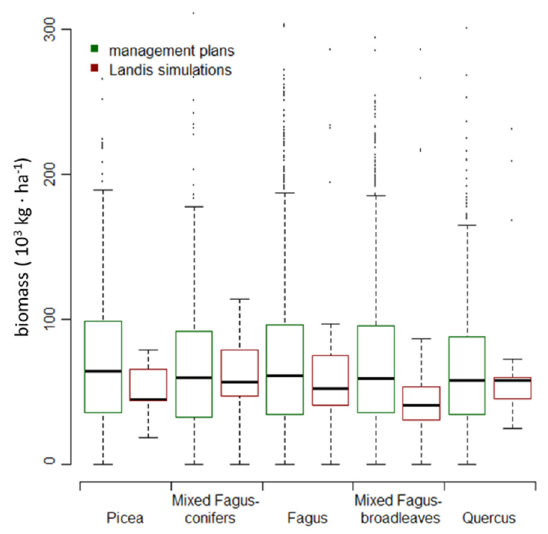
Figure 3. Boxplot diagram comparing the modeled biomass in the five main forest types in the initial Landis-II simulated landscape (year 2015) and the field-measured biomass data recorded from the management plans.